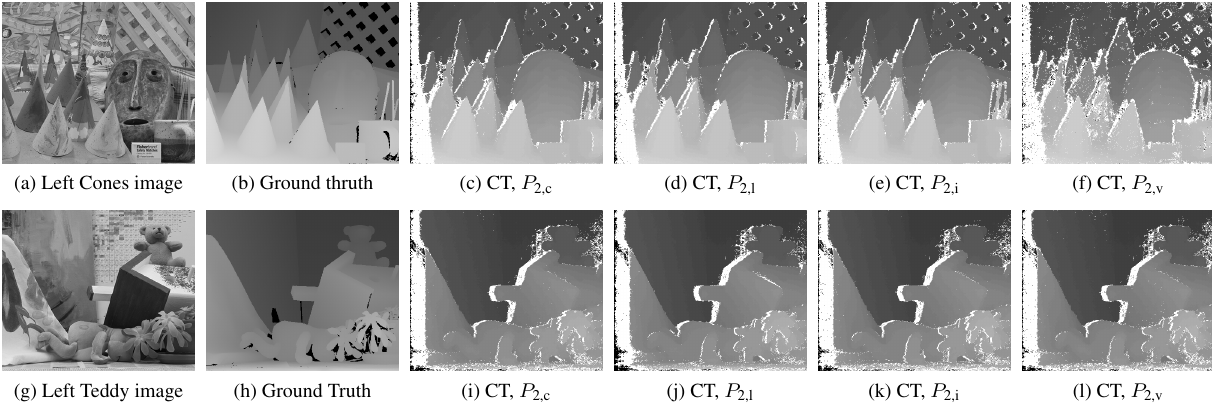
Figure 5: Disparity maps obtained with optimally parametrized penalty functions for Cones (top row) and Teddy (bottom row). than for the census transform which is due to the missing spatial information of the rank transform. As with the census transform P 2,c performs acceptably and P 2,v poorly for an adaptive func- tion. However, in opposite to census, P 2,l always outperforms P 2,i ; in 3 cases quite significantly. All functions are similarly robust towards parametrization offset as with census (data not shown). Again, good configurations coincide across all images (data not